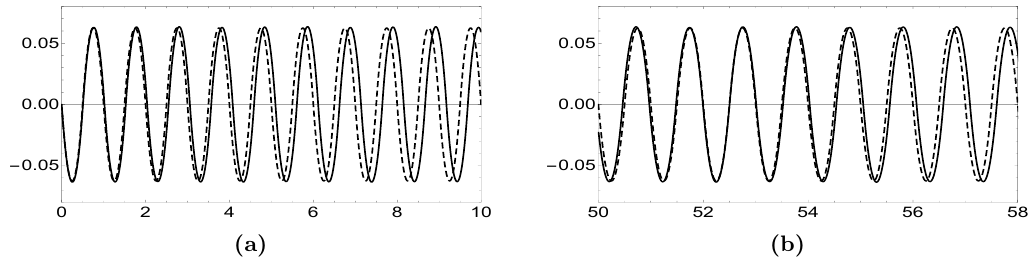
Figure 17. Numerical solution (cid:17) ( t; 1 ) (solid line) in the perturbed model with l = 1 and (cid:15) = 1. 2 The exact breather solution (cid:30) ( t; 1 ) (dashed line) is given by dashed line. The (cid:12)gures correspond to 2 (a) t 2 [0 ; 10] and (b) t 2 [50 ; 58].